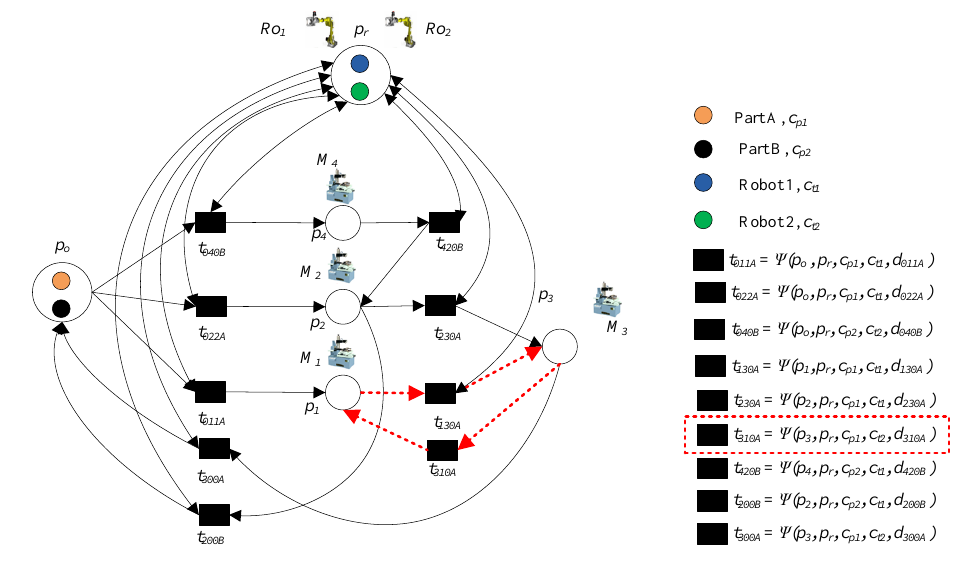
Figure 8. An ICTPN for the reconfigured system by rework.